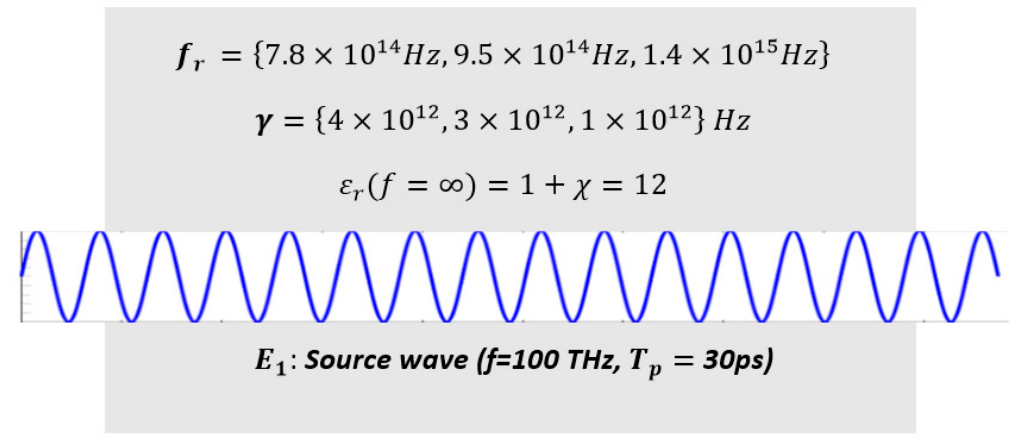
Figure 11. Configuration for Example 5.1.